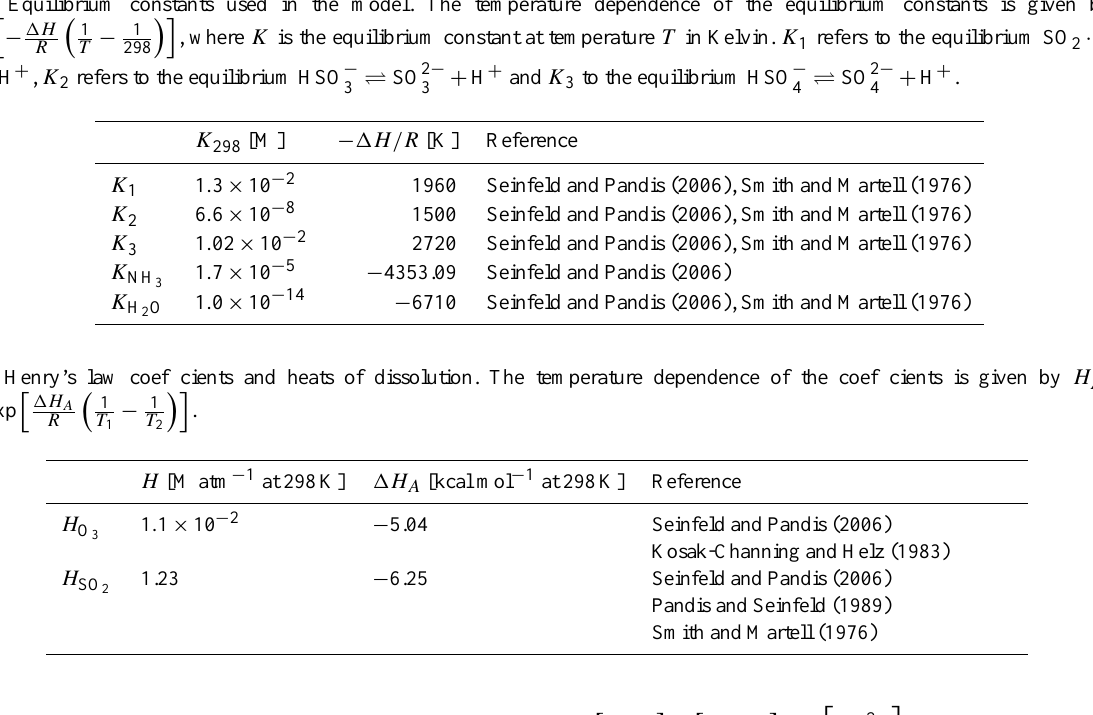
Table 1. Equilibrium constants used in the model. The temperature dependence of the equilibrium constants is given by K =